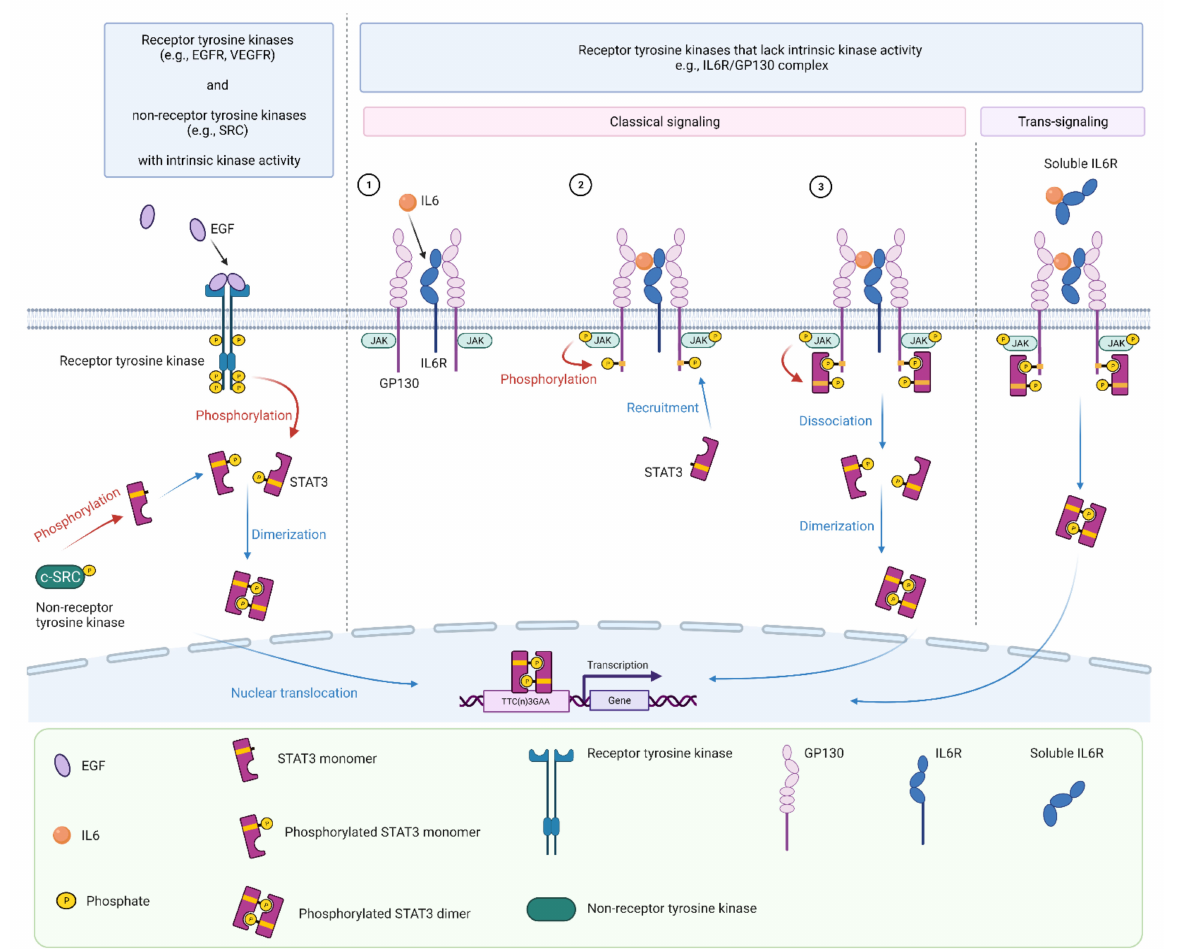
Figure 2. Overview of STAT3 activation. Receptor tyrosine kinases such as EGFR and VEGFR have intrinsic kinase abilities and can directly phosphorylate STAT3 following ligand binding. Receptor independent tyrosine kinases such as c-SRC can also phosphorylate JAK. For receptors that lack intrinsic tyrosine kinase activity, such as the IL6R/GP130 complex, STAT3 activation is initiated upon ligand-receptor interactions (1). Activated JAKs phosphorylate the cytoplasmic tail of the receptor subunit, which serves as a docking site for STAT3 (2). STAT3 is then phosphorylated by JAK, dissociates from the receptor, and forms homodimers that translocate into the nucleus to mediate gene transcription by binding to the TTC(n)3GAA promoter sequence (3). In the alternative trans-signaling pathway, IL6 binds to a soluble IL6 receptor, which then associates with GP130 to initiate downstream STAT3 signaling as per the classical pathway. Figure created in